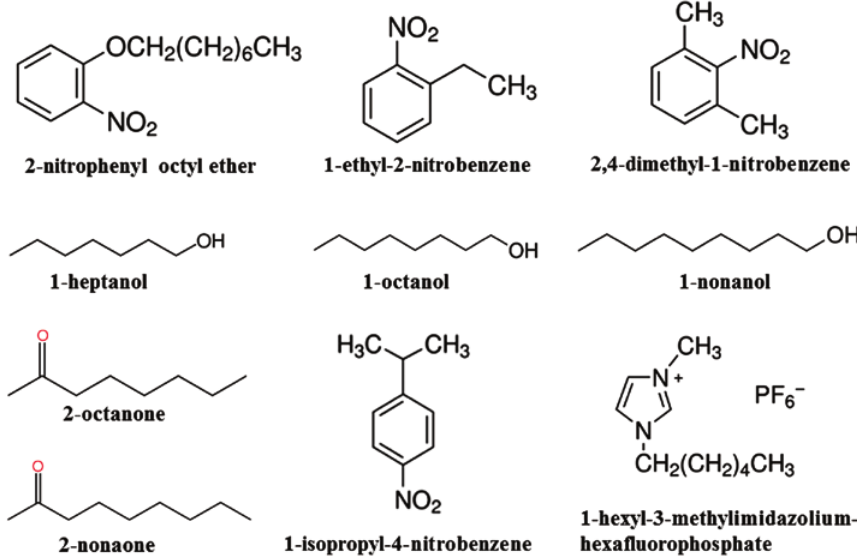
Figure 3: Structures for the representatives of organic solvents in